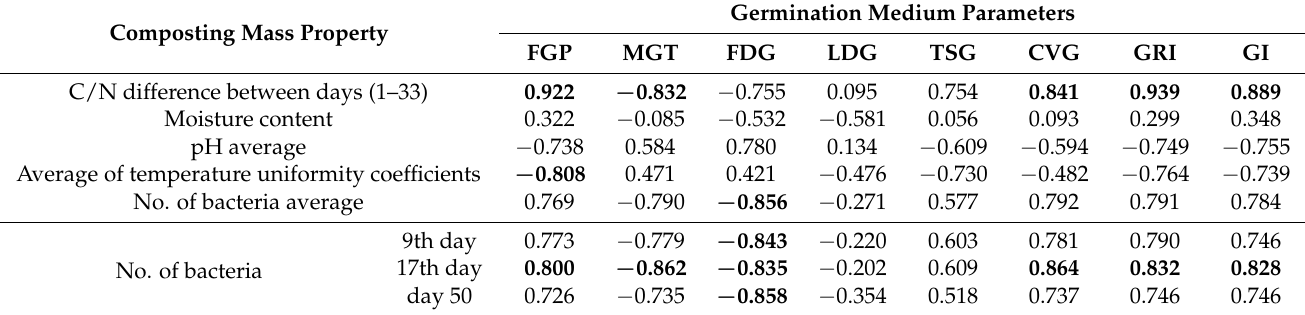
Figure 9. Microbial population on days 9, 17 and 50 of composting for ( A ) bacteria; ( B ) fungi; and ( C ) actinomycetes. Table 4. Correlation coefficients between germination parameters of mediums and some parameters of